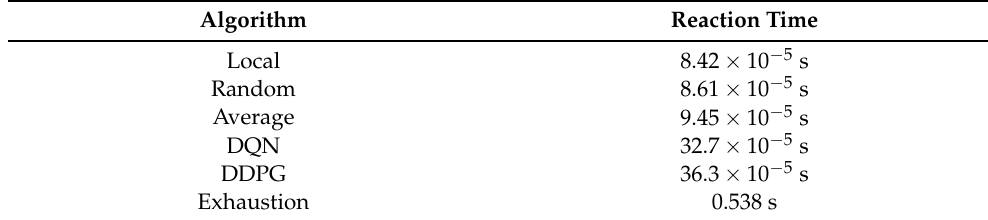
Table 4. Comparison of the reaction time of tasks.